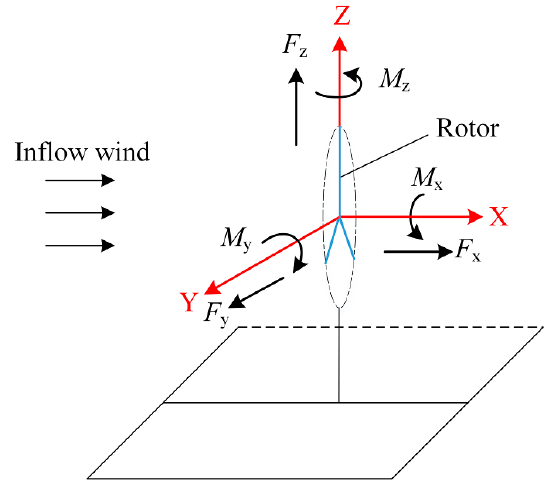
Figure 8. Schematic of the reference coordinate system and aerodynamic loads.